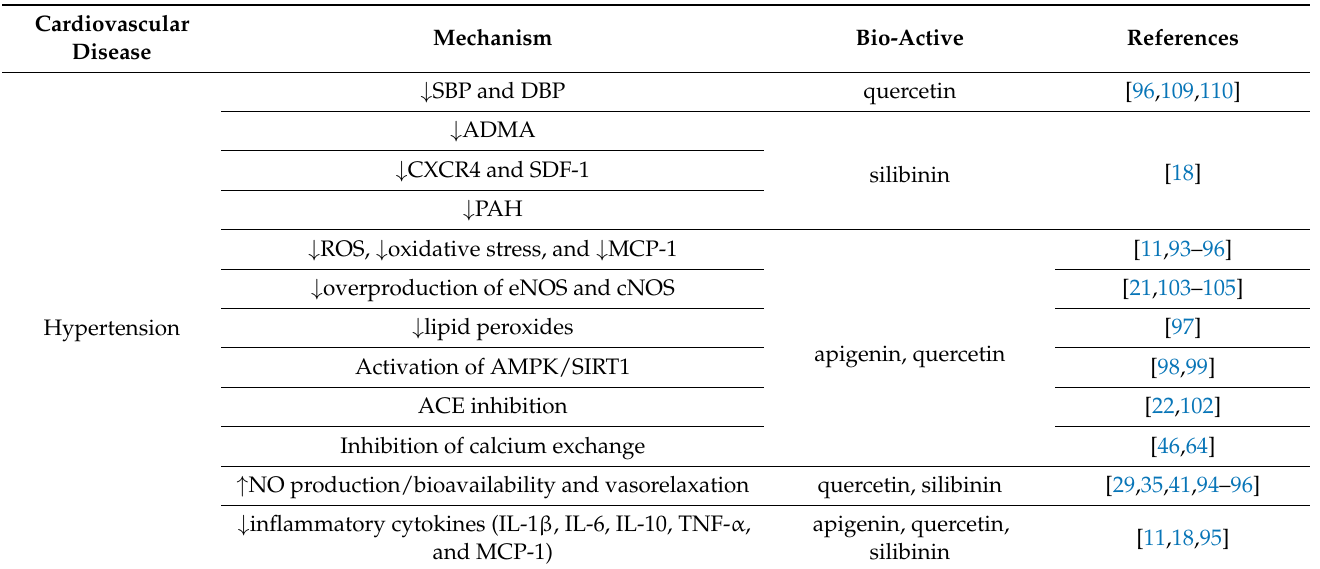
Table 2. Published preclinical studies based on the cardioprotective properties of apigenin, quercetin, and